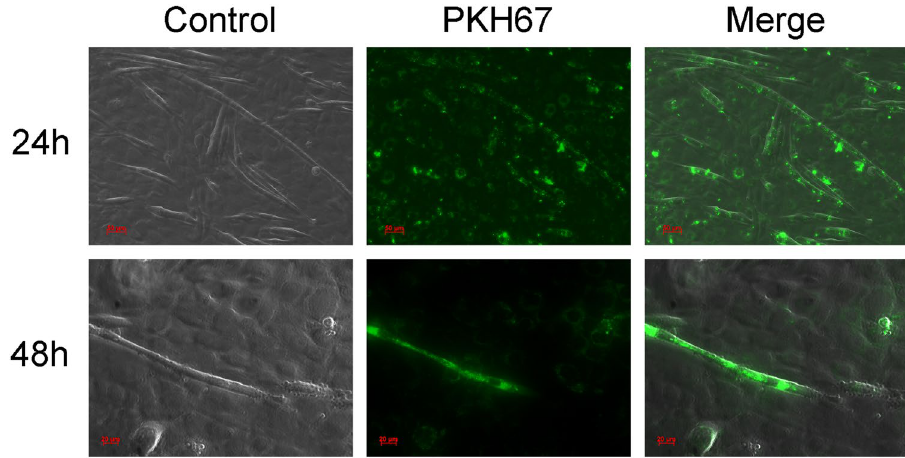
Figure 1. KPC-exosomes readily enter C2C12 cells. Fluorescence microscopy of differentiated C2C12 cells after co-incubation with 20 μ g/ml PKH67-dyed KPC-exosomes (green) for 24 hours and 48 hours. Scale bar, 20 µ m, 50 µ